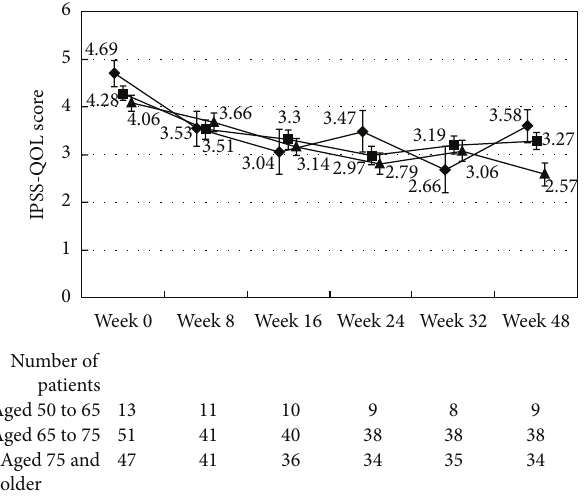
Figure 10: International Prostate Symptom Score quality of life score. The scores in the patients aged 50 to 65 ( ⧫ ), the patients aged from 65 to 75 ( ◼ ), and the patients aged from 75 and older ( 󳵳 ) are shown. The values are LS mean ± SE. 𝑃 = 0.0001 (repeated ANOVA).